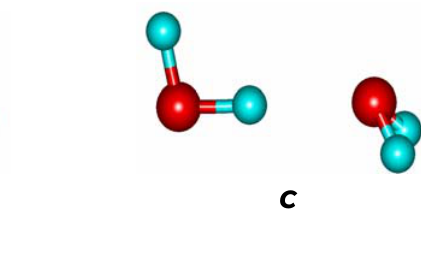
Figure 1. Linear ( a ), inverted ( b ), and bifurcated ( c ) water